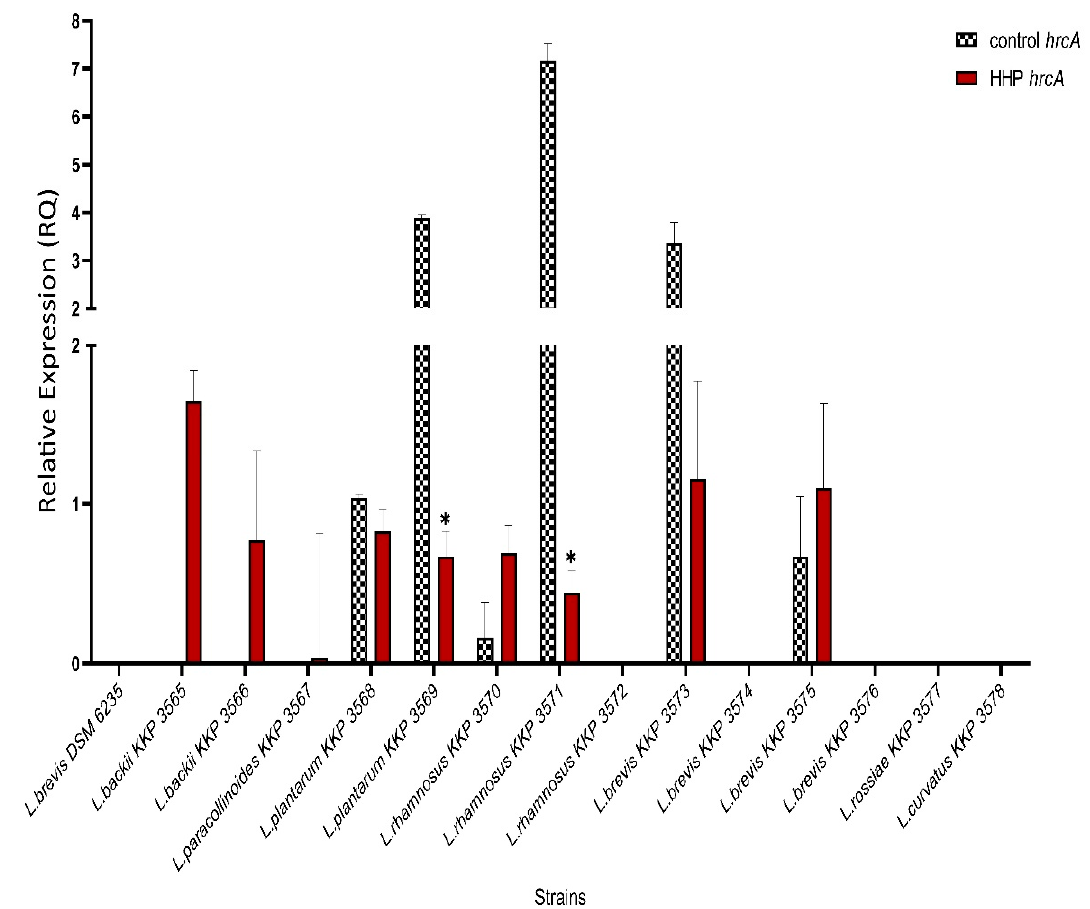
Figure 4. Relative gene expression of hrcA in LAB strains before and after exposure to 300 MPa pressure for 5 min determined by RT-qPCR analysis. Presented data are the mean of the two independent experiments and the standard deviations are indicated with vertical bars. * Statistically significant differences were determined by Student’s t -test ( p < 0.05).